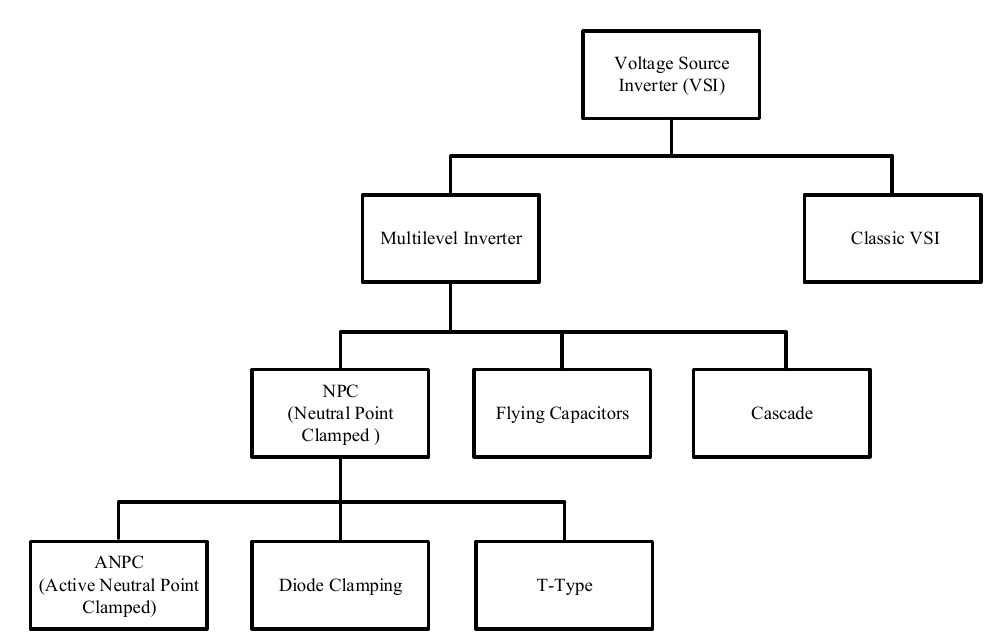
Figure 1. DC-AC converter classification.